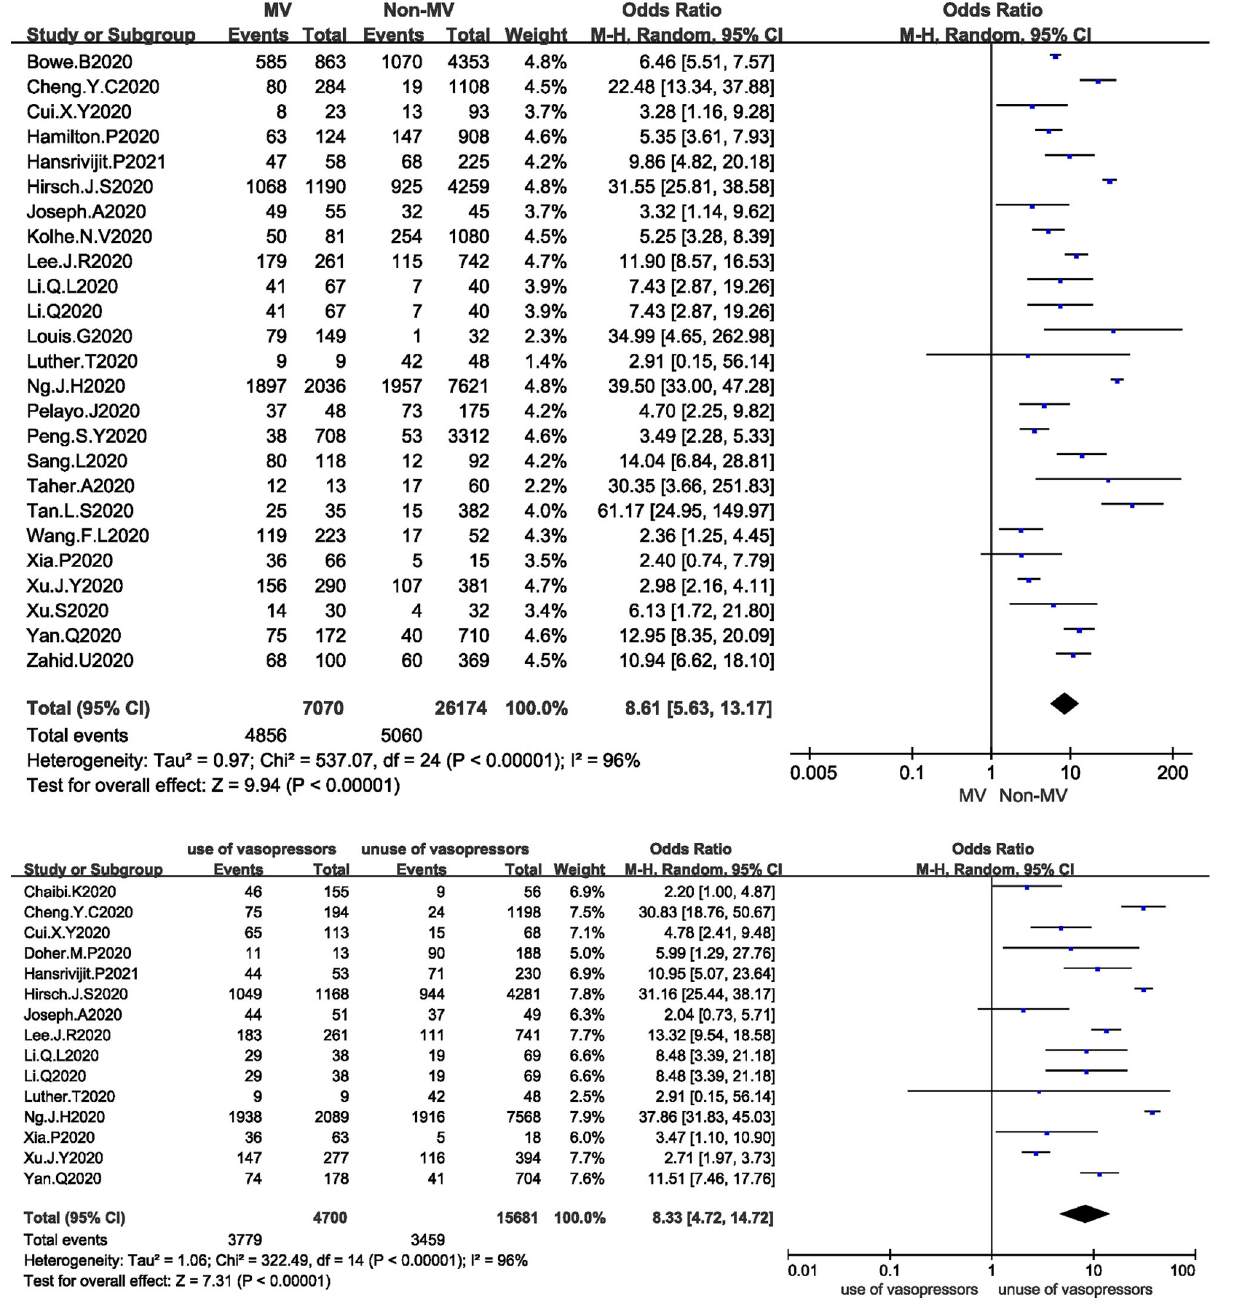
FIGURE 4 | (A) Forest plot showing the relationship between mechanical ventilation and AKI in COVID-19 patients. (B) Forest plot showing the relationship between the use of vasopressors and AKI in COVID-19 patients.